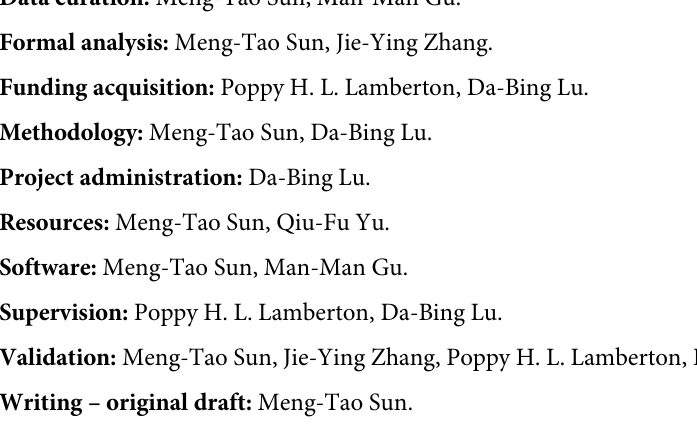
S1 Table. PRISMA checklist. S1 Fig. Risk of bias and applicability concerns summary (A) and graph